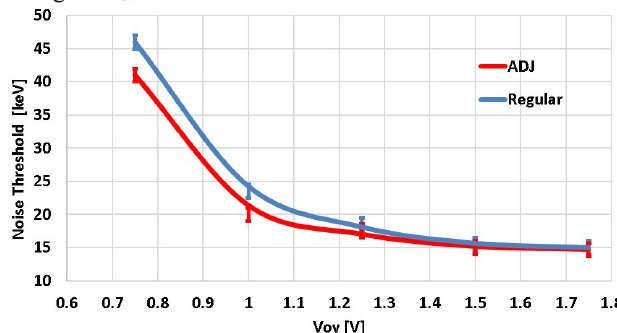
Fig. 10. Noise threshold curve as a function of Vov without the presented topology, ”Regular”, and with the suggested topology,